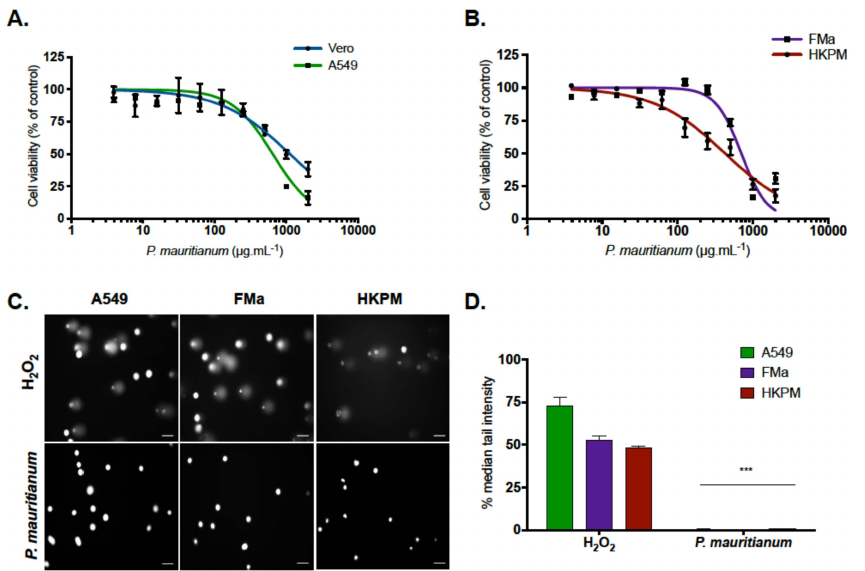
Figure 1. The cytotoxicity and genotoxicity of the P. mauritianum extract on mammalian cells. ( A ) Vero and A549 cells were incubated with di ff erent concentrations of the P. mauritianum extract for 24 h. The cell viability was determined using the metabolic activity by an MTT assay. ( B ) Human primary keratinocytes (HKPM) and fibroblasts (FMa) were treated with an increased concentration of the P. mauritianum extract for 24 h, and their viability was evaluated by an MTT assay. ( A , B ) The results are the means ± SD of three independent experiments and are expressed as the relative value compared to untreated cells. ( C ) Human cells (A549, HKPM and FMa) were treated 24 h with 100 µ g mL − 1 of the P. mauritianum extract. The cells were treated 10 min with H 2 O 2 (50 µ M) as a positive control. The genotoxicity was determined by observation of DNA degradation using a COMET assay visualized by Gel Red. The images are representative of three independent experiments. Scale bars are 50 µ m. ( D ) The quantification of the COMET signal from the experiments represented in the images by using a COMET assay IV software. The results are means ± SD of three independent experiments and are expressed as the percentage of the tail intensity. A one-way ANOVA and Dunnett’s test for multiple comparisons were used for the statistical analysis (*** p <